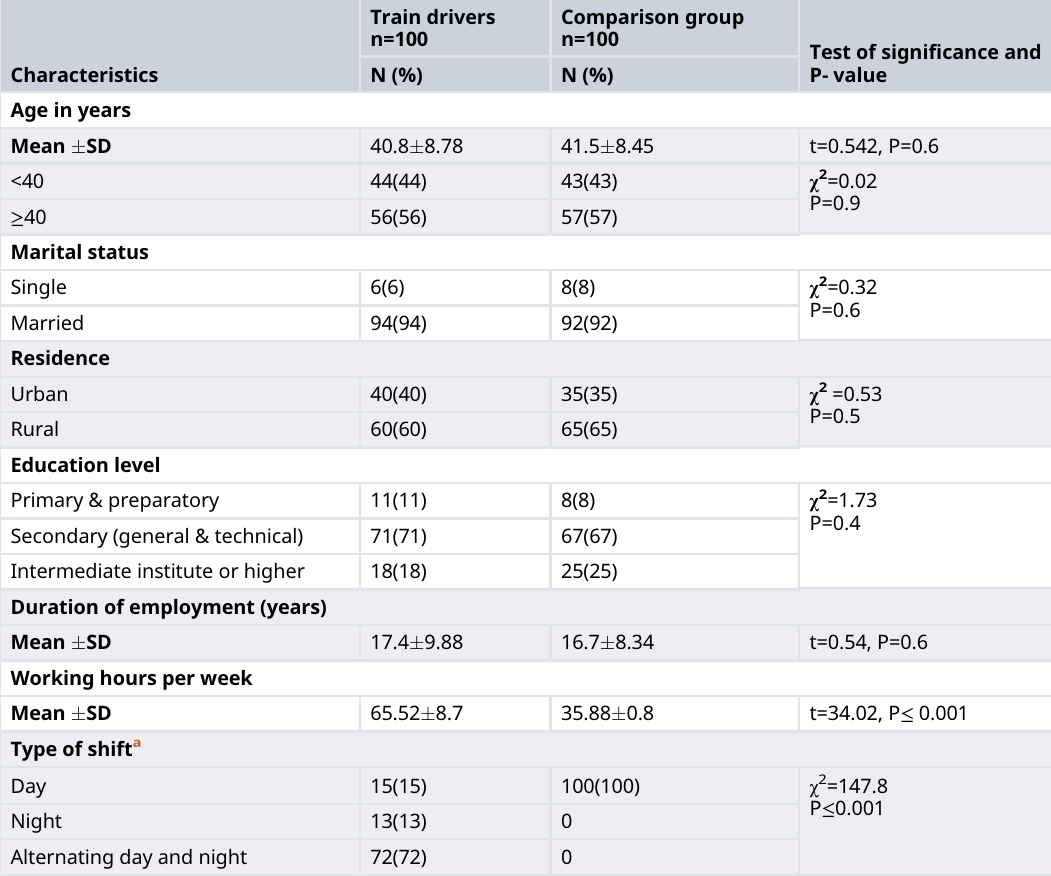
Table 1. Socio-demographic characteristics and occupational profile of the study groups.